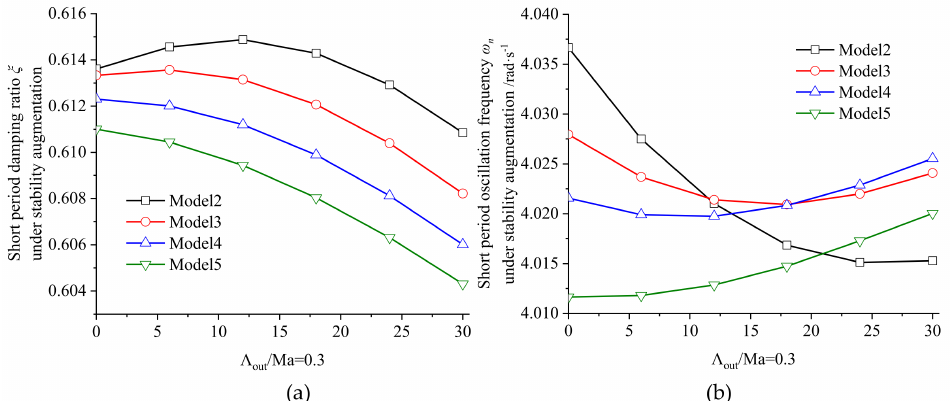
Figure 13. The short-period damping ratio ξ and oscillation frequency ω n of the UAV system after stability augmentation adjustment when Ma = 0.3. ( a ) Damping ratio ξ , ( b ) oscillation frequency ω n .